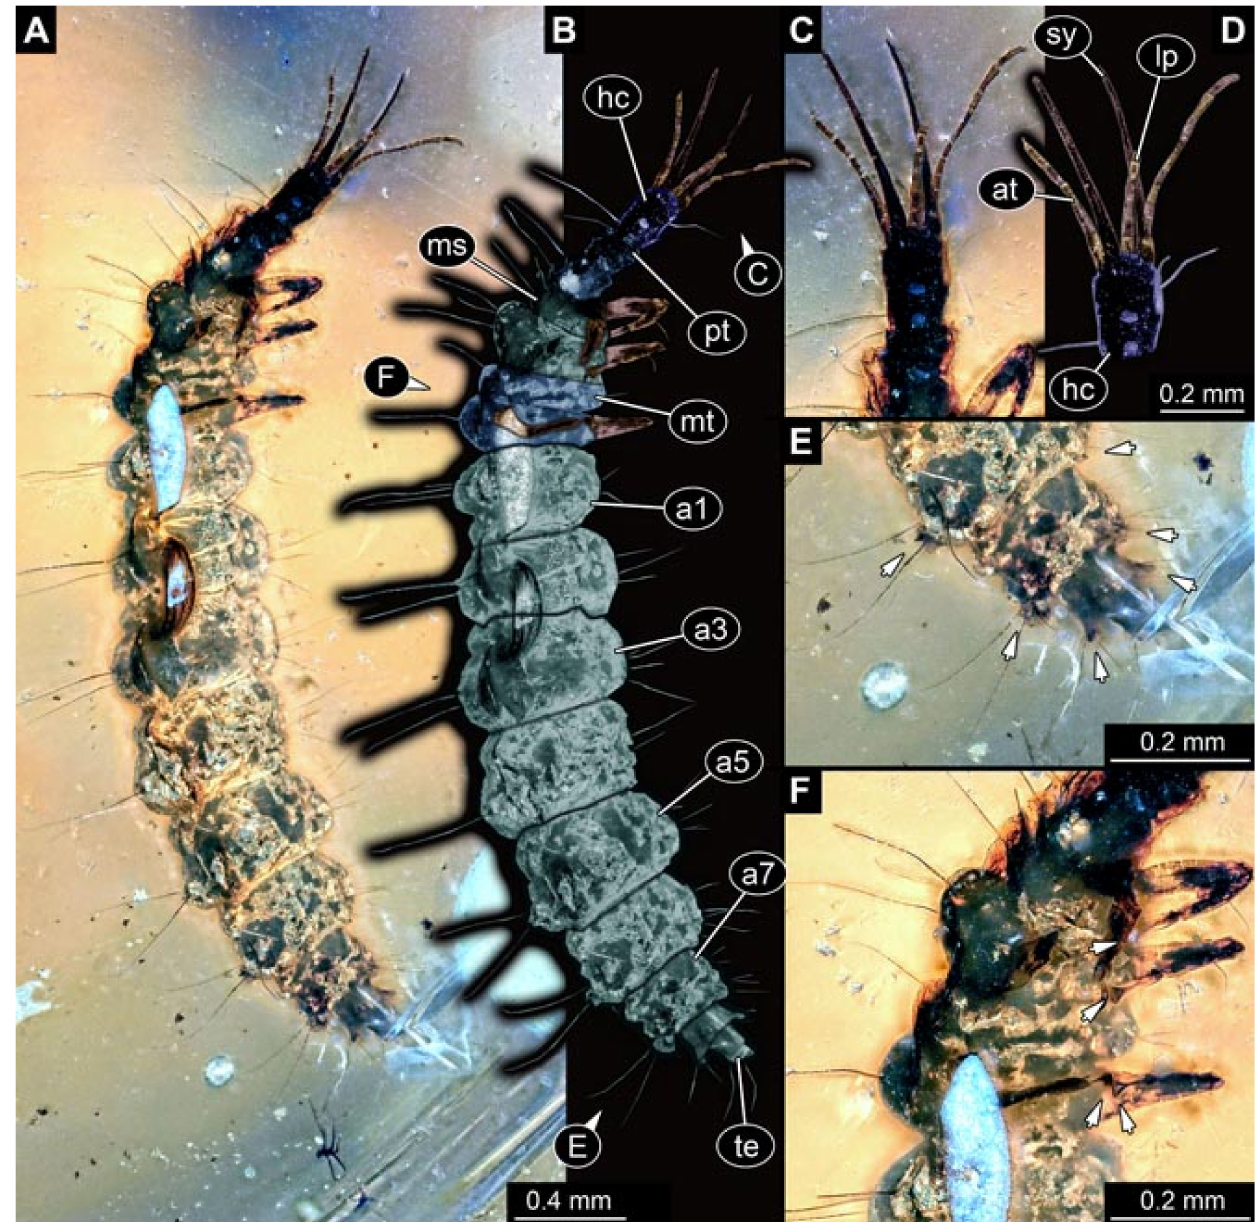
Figure 26. Specimen 5857 (BUB 0049); Myanmar amber. ( A ) Ventral view. ( B ) Ventral view, colour-marked. ( C ) Close-up of head in ventral view. ( D ) Close-up of head in ventral view, colour-marked. ( E ) Close-up of protrusions of abdomen segments (arrows) in ventral view. ( F ) Close up of trunk appendages with empodia (arrows) in ventral view. Abbreviations: a1–a7 = abdomen segments 1–7; at = antenna; hc = head capsule; lp = labial palp; ms = mesothorax; mt = metathorax; pt = prothorax; sy = stylet; te = trunk